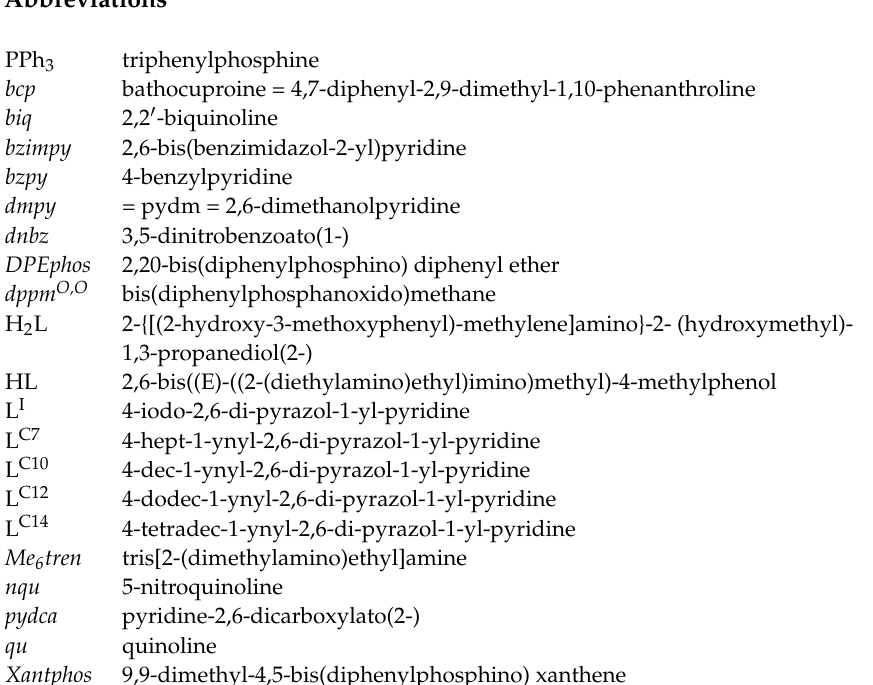
model for 1 . Solid line–convolution of three primitive curves (dotted, dashed, dot-dot-dashed). Figure S2. Test of the stability of the fitted relaxation time when 1 to 9 data points from the HF range are gradually omitted. Solid lines for individual fits are overlapped. Dashed lines: primitive low-frequency (LF) and high-frequency (HF) components. Experimental data points from [38] for [Co( biq )Cl2], 12 . Figure S3. Test of the stability of the fitted relaxation time when data points from the HF range are gradually omitted. Experimental data for a doped sample C 28 H 26 Co 0.52 N 4 O 13 Zn 1.48 ( 2b ). From: Boˇca, R.; Rajn á k, C.; Moncol’, J.; Titiš, J.; Valigura, D. Breaking the Magic Border of